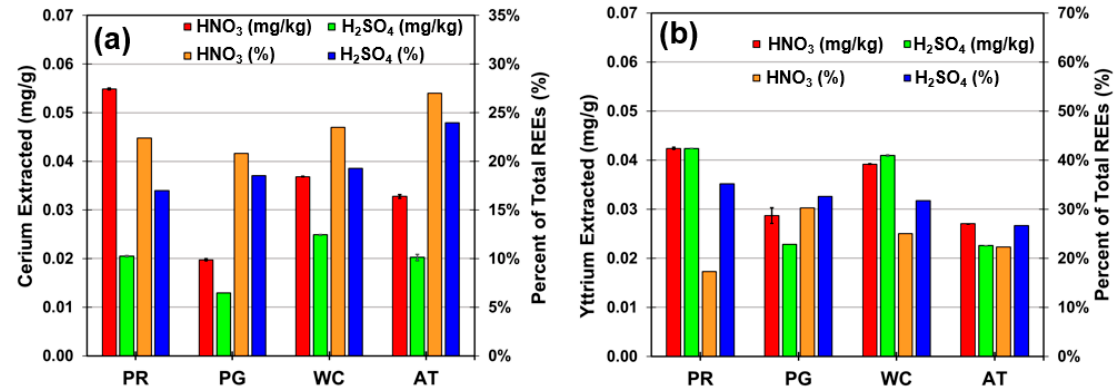
Figure 3. Extracted ( a ) cerium and ( b ) yttrium levels in HNO 3 and H 2 SO 4 .